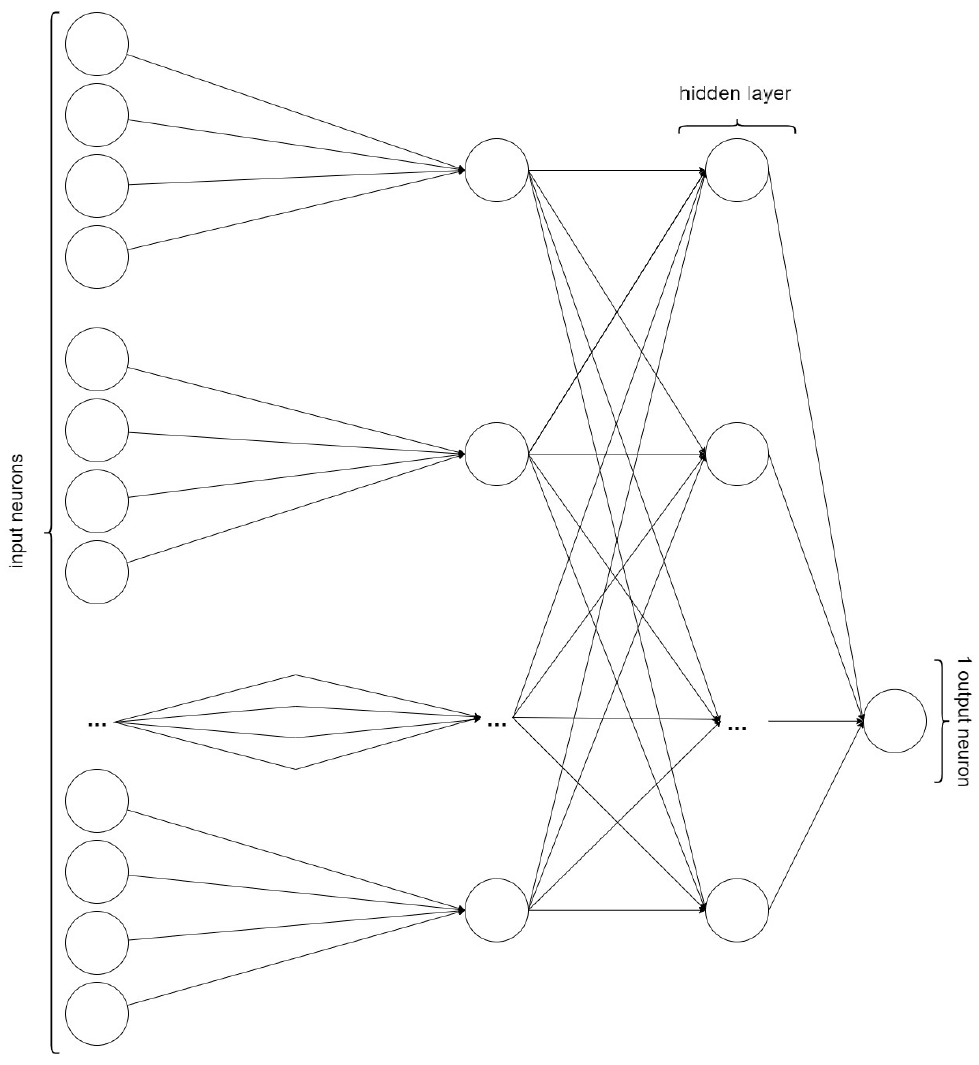
Figure 3: Ad-hoc network: input neurons are grouped by four, indicating the observations over a year of the same